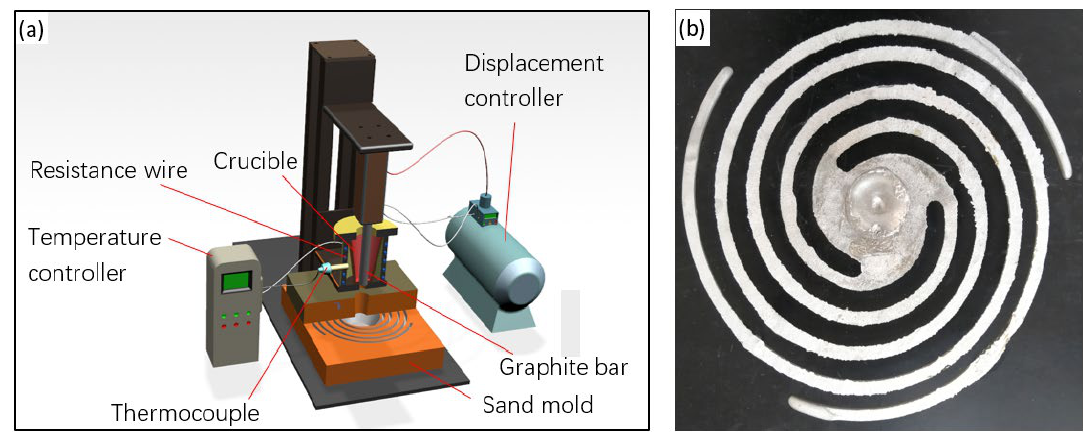
Figure 1. Schematic illustration of the fluidity test apparatus ( a ) and a typical spiral fluidity sample ( b ).